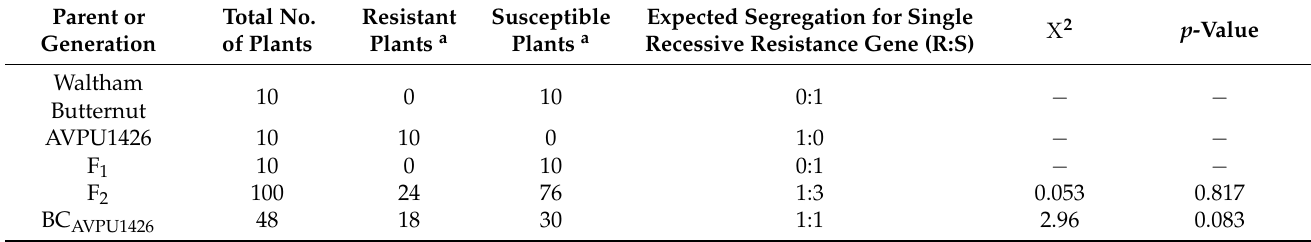
Table 2. Segregation of ToLCNDV resistance in F 1 , F 2 , and BC generations derived from the cross between AVPU1426 (resistant) and Waltham Butternut (susceptible) lines of Cucurbita moschata . No. of Resistant Susceptible Expected Segregation for Single Х 2 p -Value Parent or Cross Plants Plants a Plants a Recessive Resistance Gene (R:S) Waltham 10 0 0:1 − − Butternut AVPU1426 10 10 0 1:0 − − F 1 10 0 10 0:1 − − 100 27 BC AVPU1426 50 23 0.571 a Plants scoring 0 and 1 on the basis of their symptoms were classified as showing resistance, whereas plants scoring 2 to 4 were classified as susceptible. X 2 at 0.05 with 1 df = 3.84. Non-viruliferous whiteflies were fed separately on SLCCNV- and ToLCNDV- infected pumpkin plants for a 48 h acquisition period. Then, viruliferous whiteflies were transferred to feed on 12 days old pumpkin seedlings of all the assayed generations for 48 h. After transmission, whiteflies were killed using Amitraz (Q-FAC Co., Ltd., Phraek Sa, Mueang Samut Prakan, Thailand) and Starkle G (Sotus International Co., Ltd., Pak Kret, Nonthaburi, Thailand). Inoculated pumpkin seedlings were transplanted to 45 cm pots and kept in the greenhouse. Evaluation of SLCCNV and ToLCNDV symptoms in each plant was conducted 35 days after inoculation (dai). Symptoms were scored using the following scale: 0 = no visible symptom; 1 = very mild symptom with slightly yellow mottle; 2 = moderate symptom with yellow mottling and crinkling of leaf; 3 = severe symptom with widespread yellow mottling to the apical shoot, leaf curling; 4 = very severe symptom with stunting of plant and leaf yellowing, curling and reduction of leaf lamina or dead plants (Figure 1) [9]. Plants with scores 0–1 were considered resistant. Segregation ratios were compared to the expected ratios with the Chi-square test ( χ 2 ). To test the presence of SLCCNV and ToLCNDV in all the plants of parental lines, F1 and segregating populations, DNA was isolated from the collected samples and subjected to PCR amplification using SLCCNV specific primers Beg434F (GAACTATGKCGAAGCGWCCAG; K = T or G, W = A or